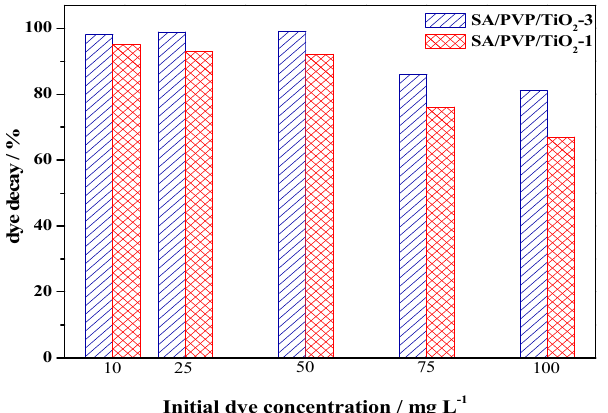
Figure 7. Effect of the initial concentration of MB dye on its photocatalytic decay using the nanocomposite beads (pH: 7; contact time: 120 min; light intensity: 1200 lm).